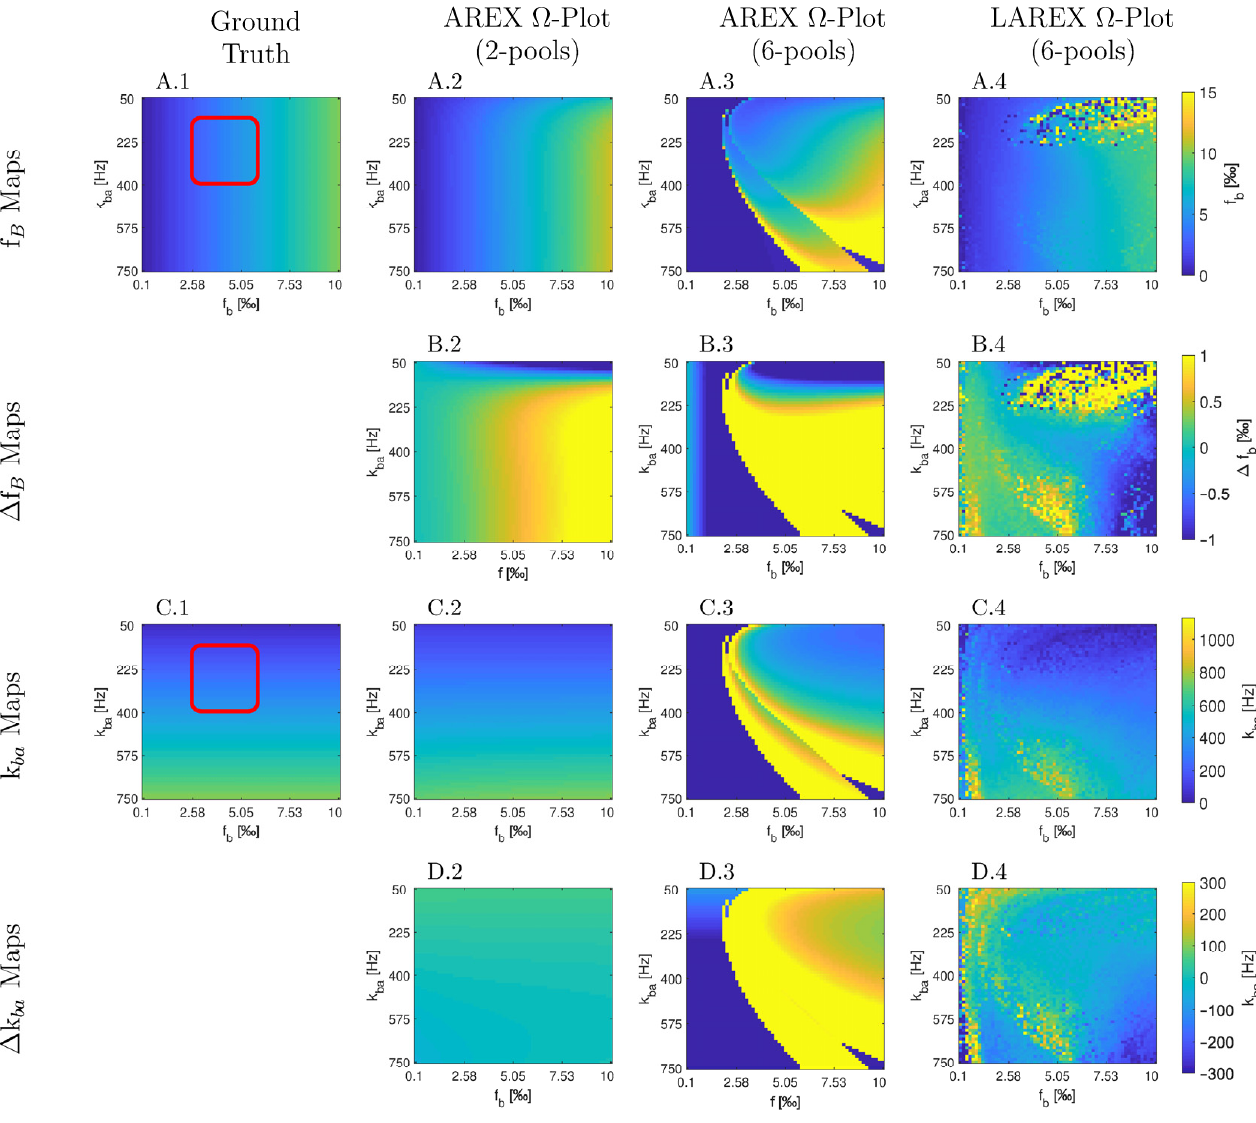
Figure A3. In silico Appendix Study 3—Amine qCEST analyses of the human ex-vivo blood. Parameter maps ( A , C ) and color-coded error maps ( B , D ) for fractional Amine concentrations f b and APT exchange rates k ba as a function of f b and k ba . The study was performed using a 6-pool system and a field strength of 7 Tesla. The parameters of the exchanging proton pools were: Water (T 1 = 2249 ms, T 2 = 48.5 ms, and ∆ s = 0 ppm); Amine (T 1 = 1000 ms, T 2 = 10 ms, f = variable 0.0001–0.01, k ba = variable 50–750 Hz and ∆ = 2.2); APT (T 1 = 1000 ms, T 2 = 0.5 ms, f = 0.0078, k ba = 338.7 and ∆ s = 3.5); NOE #1 (T 1 = 1000 ms, T 2 = 1.2 ms, f = 0.018, k ba = 10 Hz and ∆ = − 1.7 ppm); NOE #2 (T 1 = 1000 ms, T 2 = 0.5 ms, f = 0.0144, k ba = 5 Hz and ∆ s = − 3.5); MT (T 1 = 1000 ms, T 2 = 0.01 ms, f = 0.0105, k ba = 15 and ∆ = − 2.34), and were based on the results of Shah et al. [68]. Furthermore, analogous to the in silico, in situ, and in vivo experiments, the same MR parameters (TR = 2500 ms, TE = 3.5 ms) and presaturation parameters (n p = 40, t p = 100 ms, t d = 100 ms, presaturation pulse shape = Gaussian, ∆ ω = 5 ppm) were